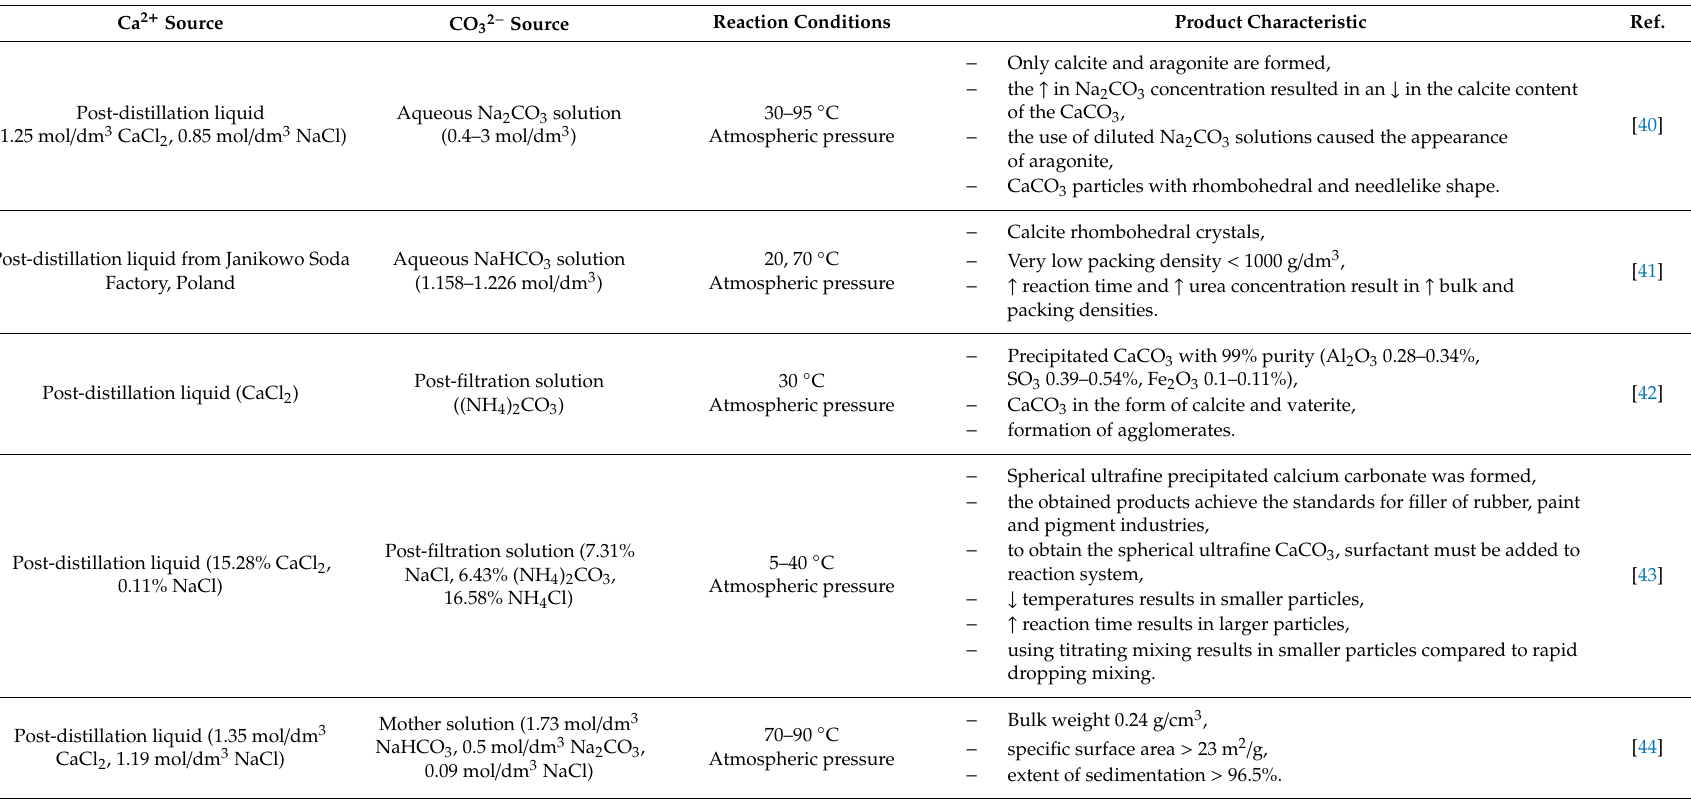
Table 1. Process parameters of CaCO 3 precipitation technologies for Solvay post-distillation liquid utilization using liquid-liquid